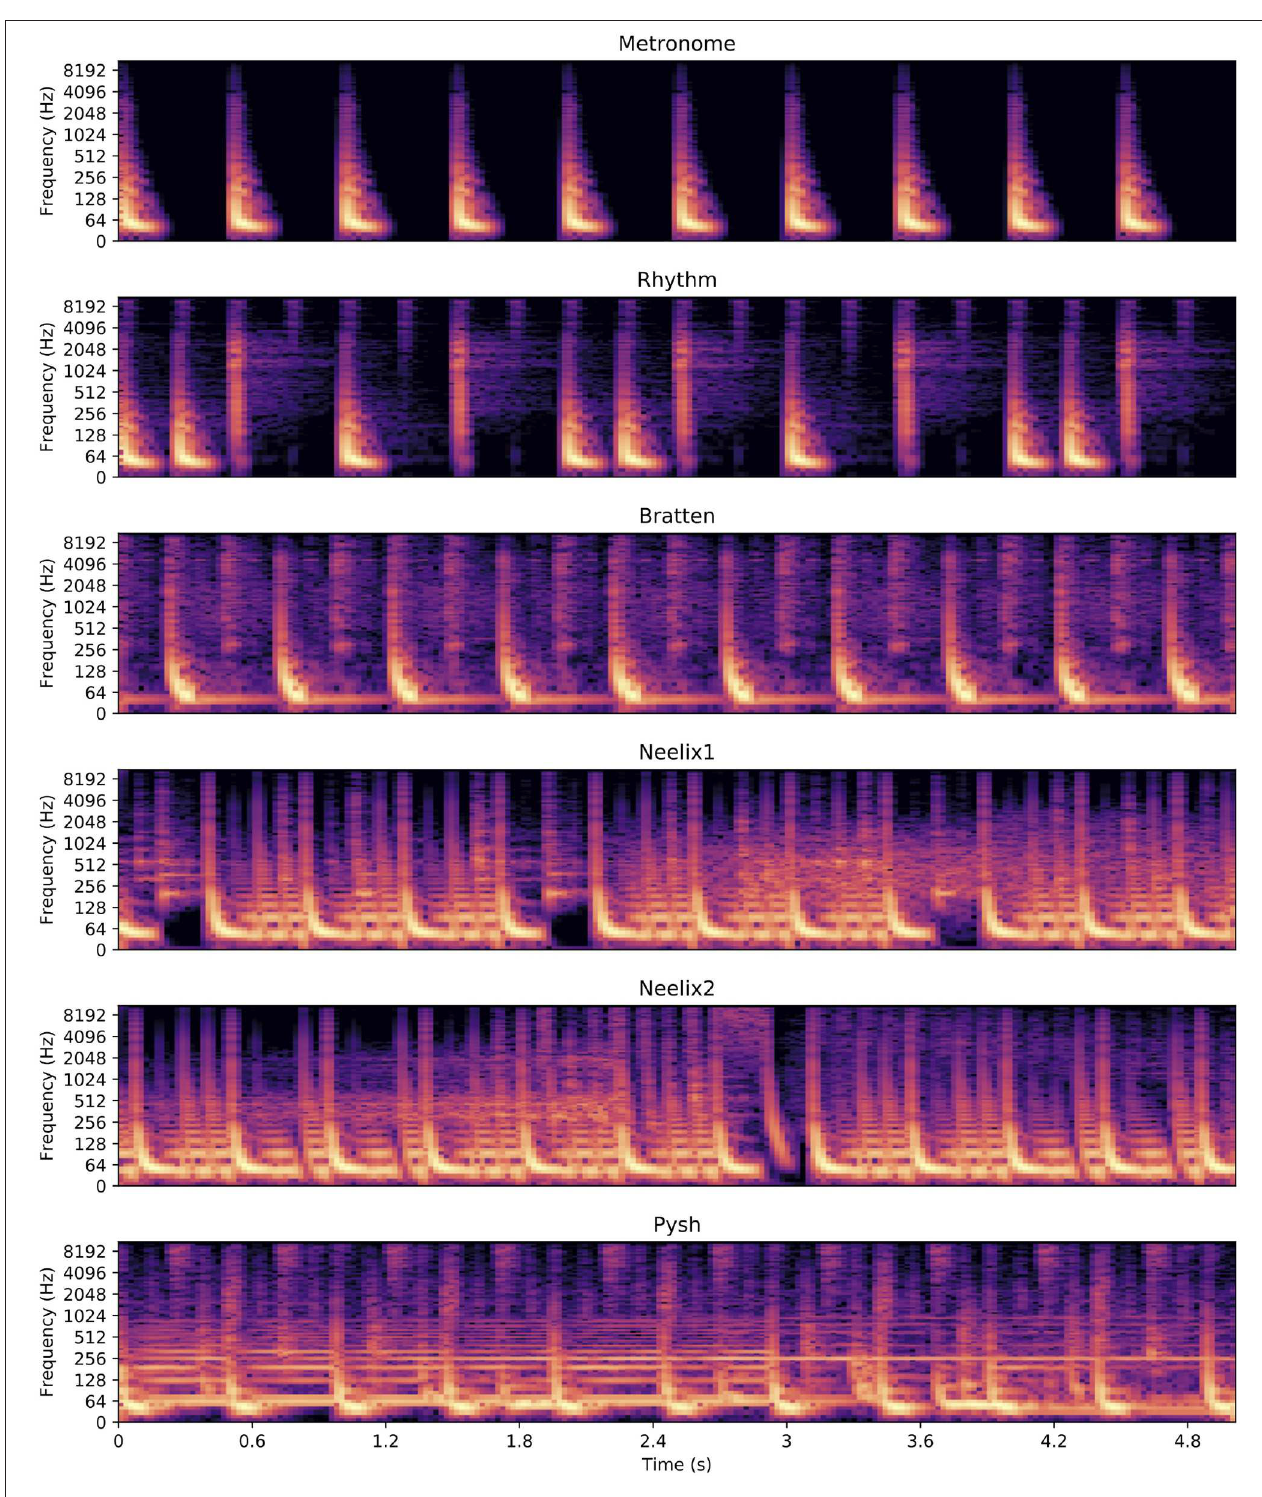
FIGURE 2 | Spectrograms of 5 s of each of the six sound stimuli. These close-ups reveal the differences in musical complexity between the different tracks: low for the metronome (top) and higher for the EDM tracks (bottom).